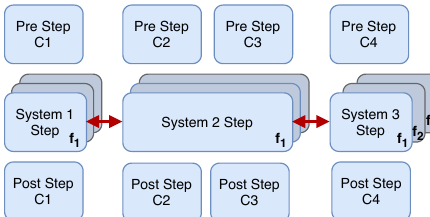
Figure 7. Parallel solution of decoupled subsystems for each set of dynamic phasors associated to the same shifting